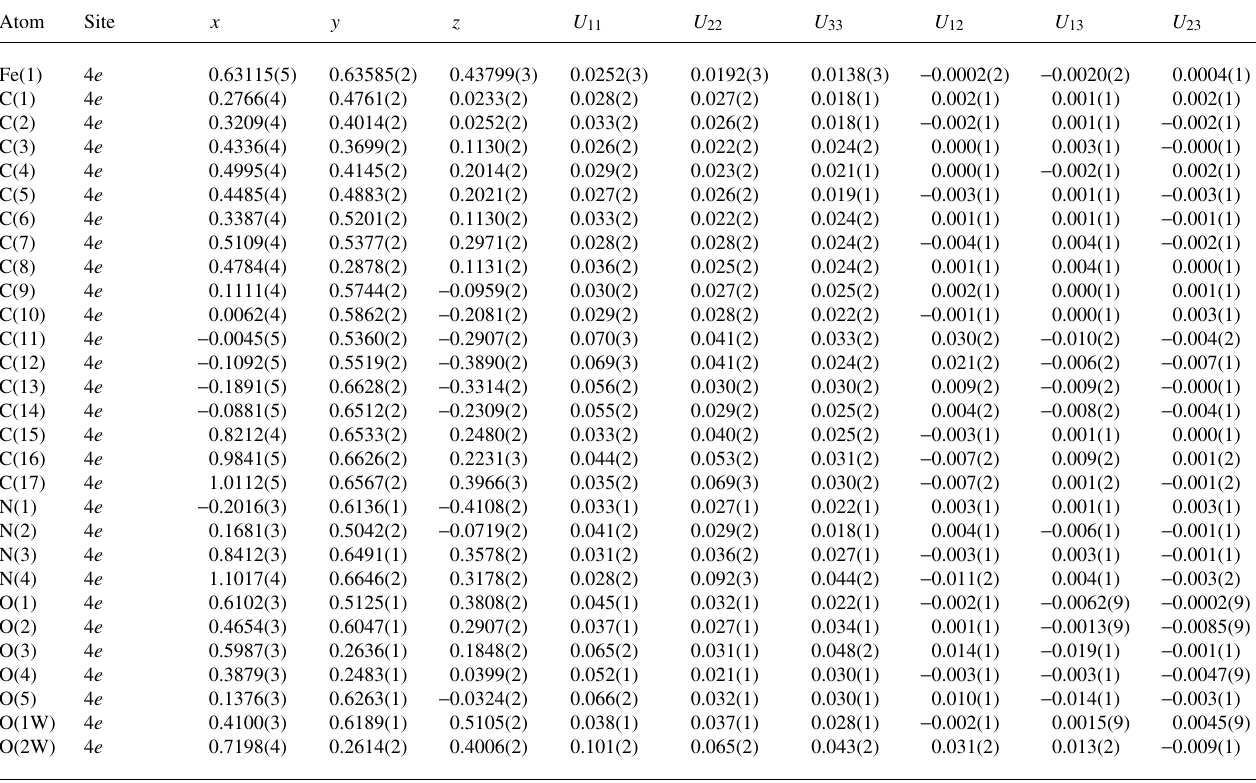
Table 3. Atomic coordinates and displacement parameters (in Å 2 )